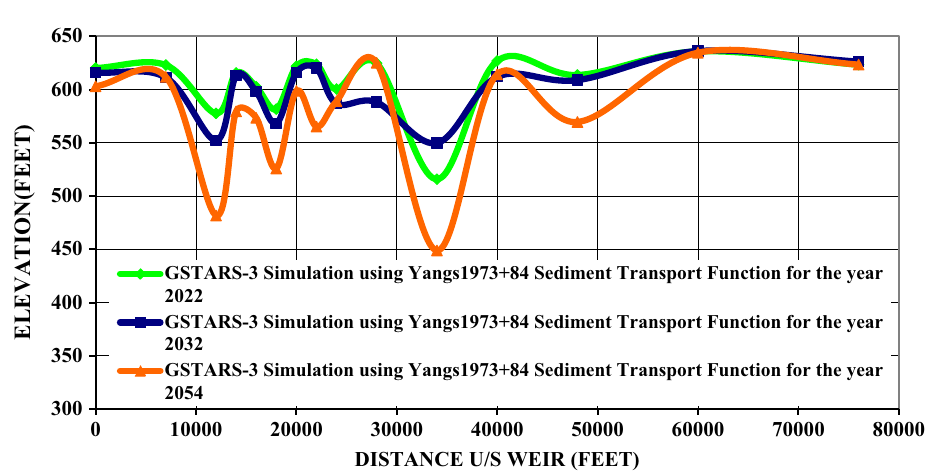
Fig. 9 Simulation results for scenario-4